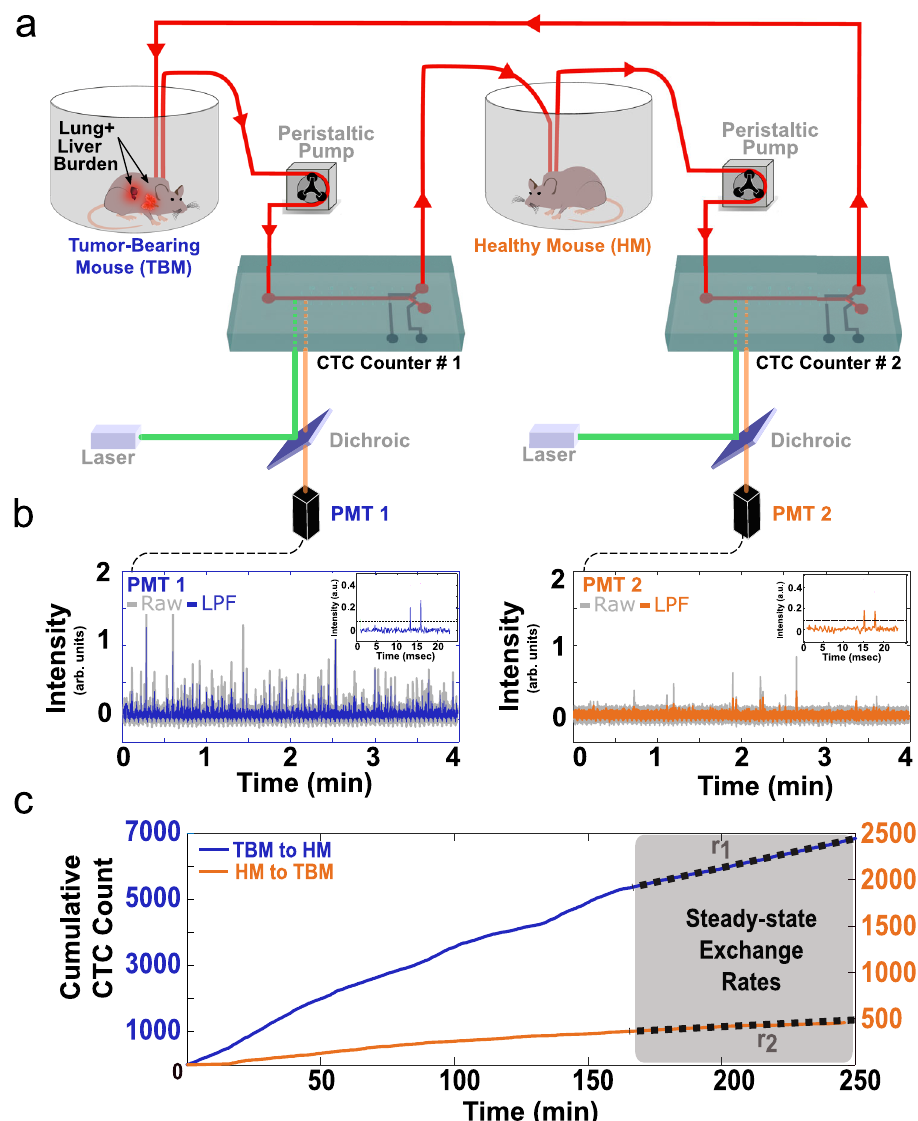
Fig. 1 A blood-exchange method for direct CTC kinetics studies. a Schematic demonstrating the blood exchange method in which the circulatory systems of two mice (one tumor-bearing mouse (TBM) and one healthy mouse (HM)) are connected in a closed-loop through two CTC counters. Two peristaltic pumps set to identical fl ow rates push the blood around the system and through the CTC counters. For each CTC counter, a series of two laser lines is used to excite the fl owing genetically- fl uorescent CTCs (see Supplementary Figs. 1 − 3 for more details). The emitted signal is directed through a dichroic fi lter toward a photomultiplier tube (PMT) for detection. b PMT raw and lowpass- fi ltered (LPF) spectra demonstrate a series of detected CTCs by each of the two CTC counters ’ PMTs (PMT 1 = CTC counter 1 (blue), PMT 2 = CTC counter 2 (orange)). The inset demonstrates the LPF dual-peak con fi guration created when each CTC passes under the two laser lines projected across the fl ow channel. c Cumulative CTC counts over time from the two CTC counters demonstrate a higher injection rate (blue trajectory with left Y -axis) compared to return rate (orange trajectory with the right Y -axis). Gray- shaded regions represent the assumed steady-state time interval over which the exchange rates were